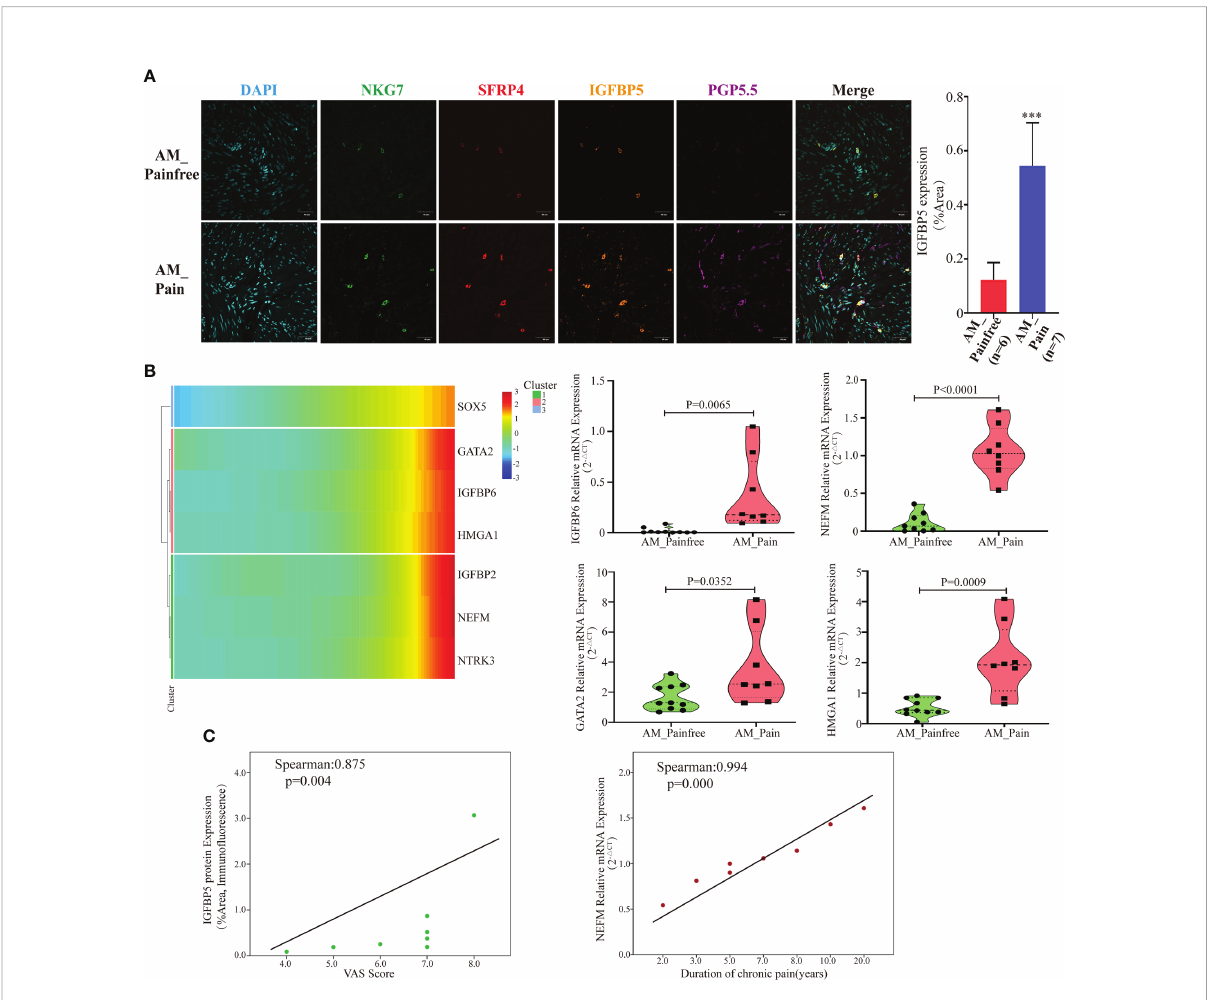
FIGURE 4 SFRP4 + IGFBP5 hi NKT cells induced neural-like cell differentiation and pain-related factor expression. (A) Immuno fl uorescence revealed